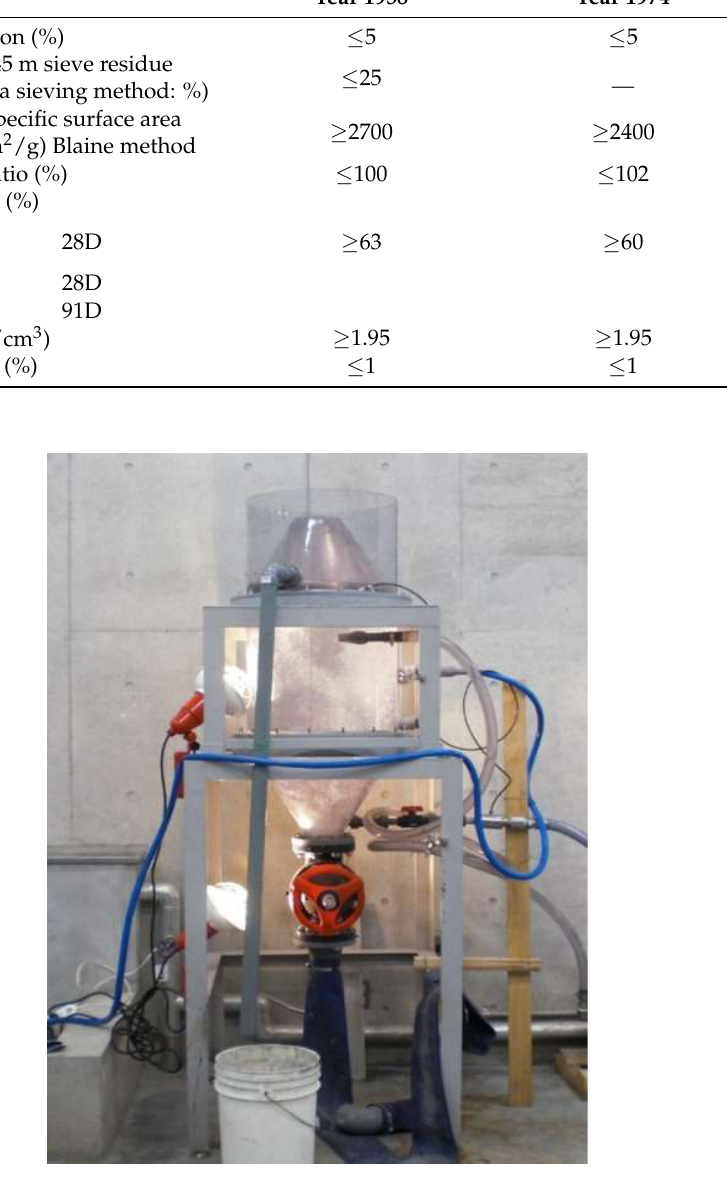
Figure 1. The flotation equipment for fly